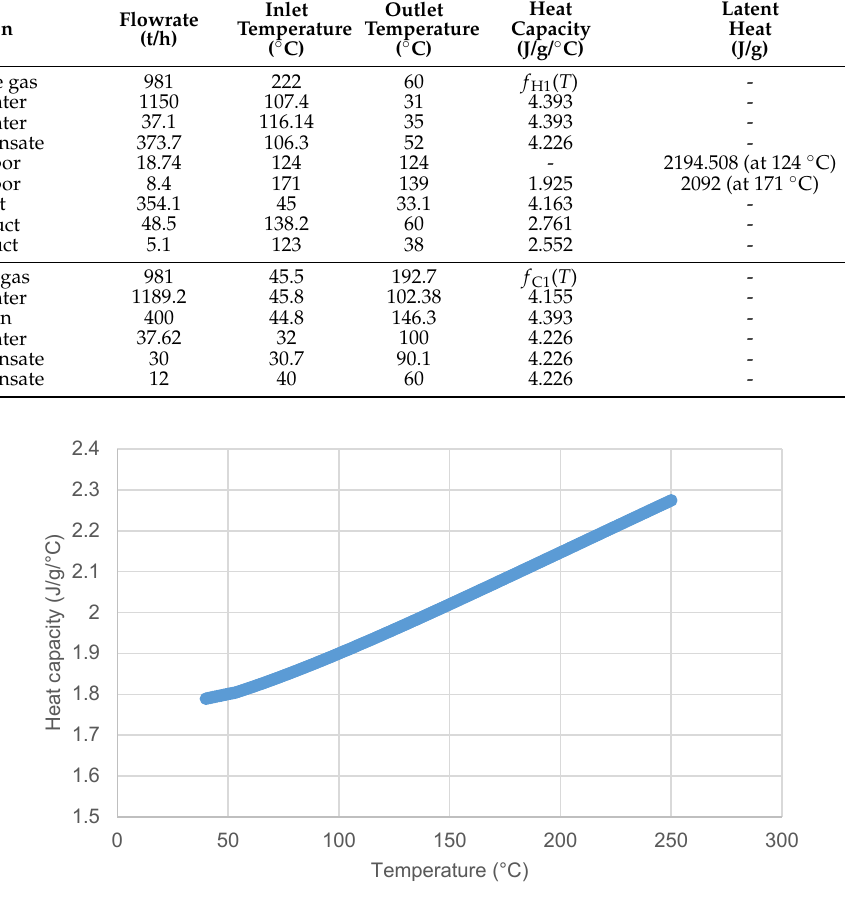
Figure 3. Heat capacity of the recycle gas.